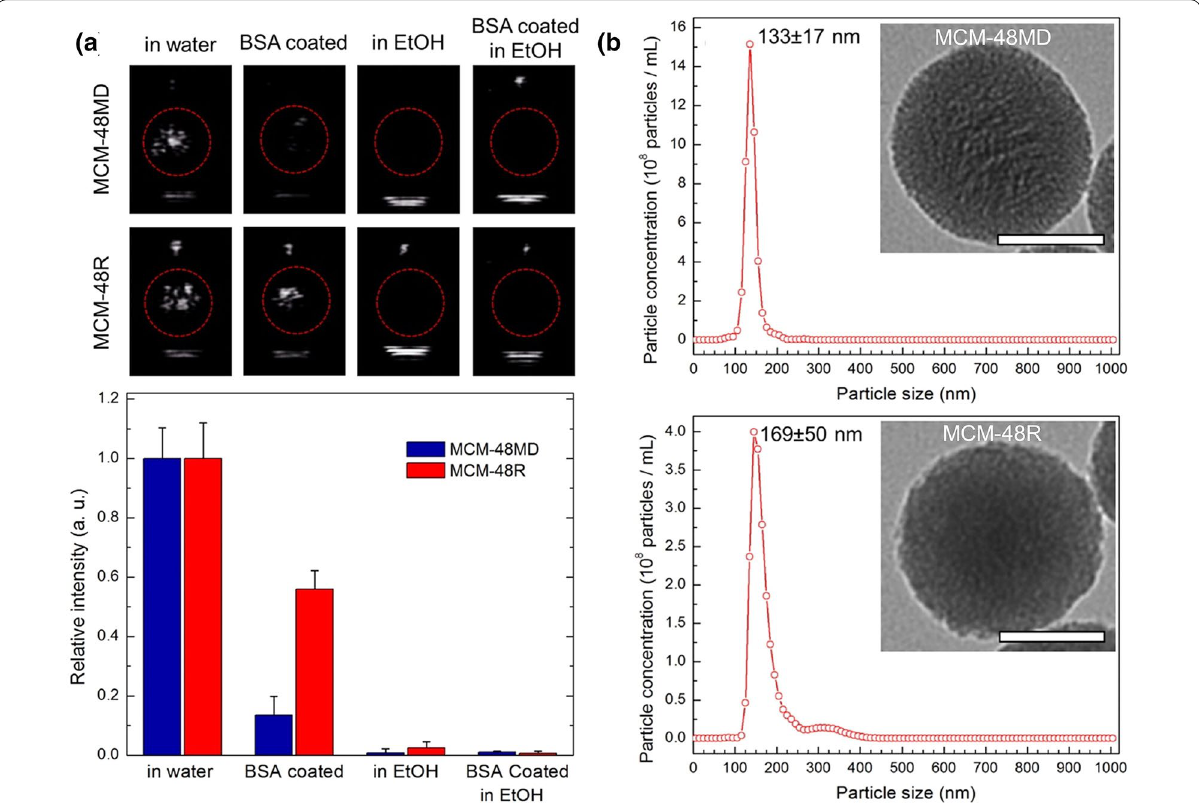
Fig. 5 a Representative images showing the cavitation events as bright spots generated by MSN based GSNs under HIFU insonation of nanoparticles with or without BSA coating in ethanol (90%) or water (top). Calculated relative intensities from the acquired movies of nanoparticles during HIFU insonation (bottom). b Nanoparticle tracking analysis of the nanoparticles in water. Insets show the TEM images. Scale bars are 50 nm. Nanoparticles; MCM-48MD: hydrophobically modified MSNs using methyltrimethoxysilane, MCM-48R: MSNs with rough nanoparticle surfaces. Adapted from reference [78], Copyright 2016, American Chemical